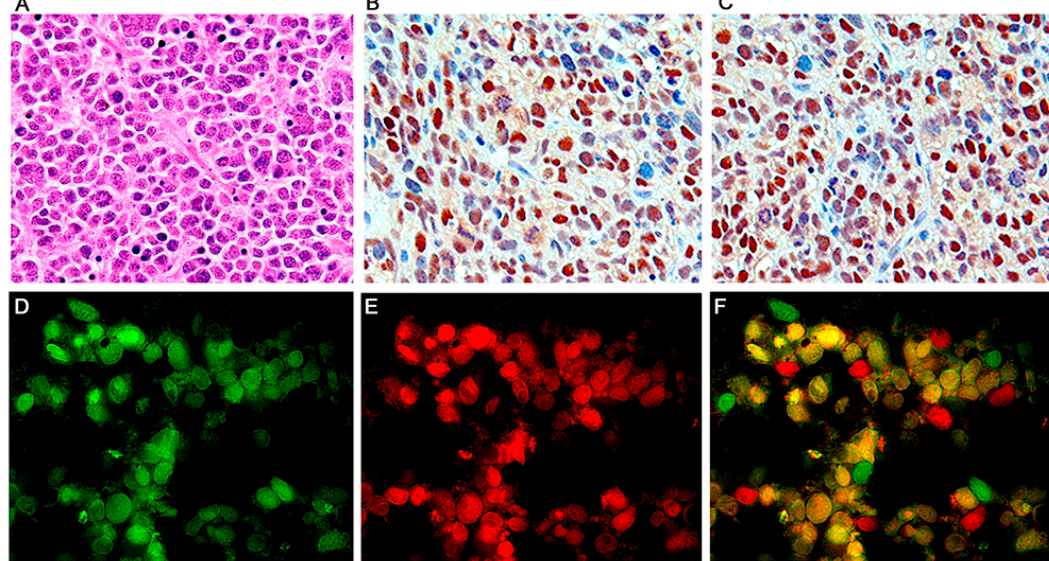
Figure 4. Primitive neuroectodermal tumors; T ‐ Antigen and cell cycle proteins. High magnification view of a PNET, formed by sheaths of numerous small basophilic cells, where mitotic figures and apoptosis bodies can be seen (Panel ( A ), hematoxylin and eosin, original magnification ×600). Immunohistochemistry for T ‐ Antigen demonstrates the nuclear localization of the protein in approximately 75–80% of the neoplastic cells. (Panel ( B )). p53 expression was robustly found in the nuclei of approximately the same number of neoplastic cells in all PNETs (Panel ( C )). Immunofluorescence with a fluorescein tagged antibody for T ‐ Antigen reveals robust nuclear signal in neoplastic cells (Panel ( D )); p53, tagged with rhodamine is also expressed in the nuclei of the primitive neoplastic cells (Panel ( E )). Double labeling, utilizing a deconvolution microscope reveals the co ‐ localization of both proteins in the nuclear compartment (Panel ( F ), all panels original magnification ×1000).